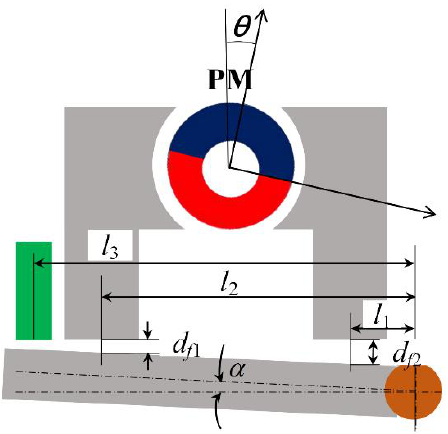
Figure 3. Model diagram of the permanent magnetic suspension system.